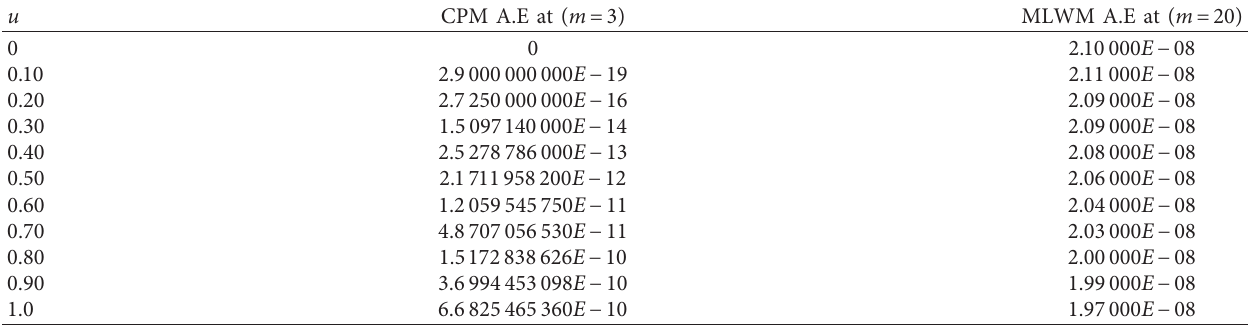
Table 4: Absolute error (A.E) comparison of CPM and other different methods for problem 2.